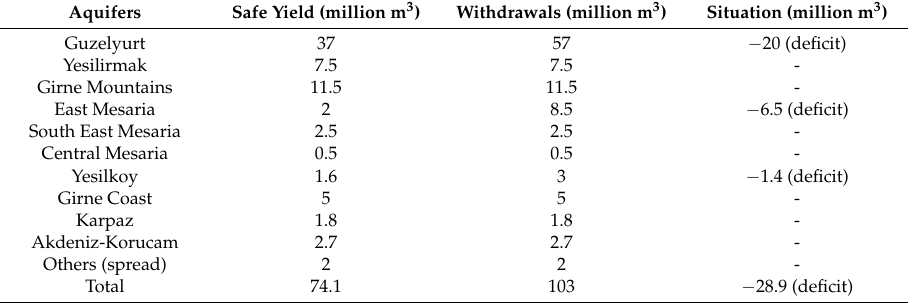
Table 2. Aquifer capacities and consequent conditions after annual extractions in NC (Department of Geology and Mines (JMD), 2002)